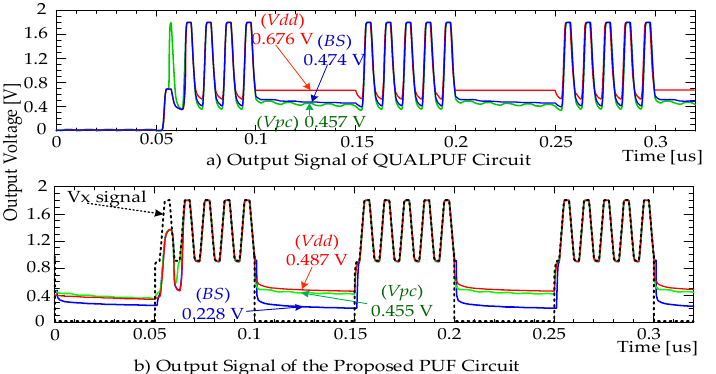
Figure 5. Evaluation result of challenge bit under the PMOS transistor body effect. PMOS bulk: tied to source (labeled as BS : body to source), tied to Vpc (labeled as Vpc) and tied to V dd (labeled as V dd ).